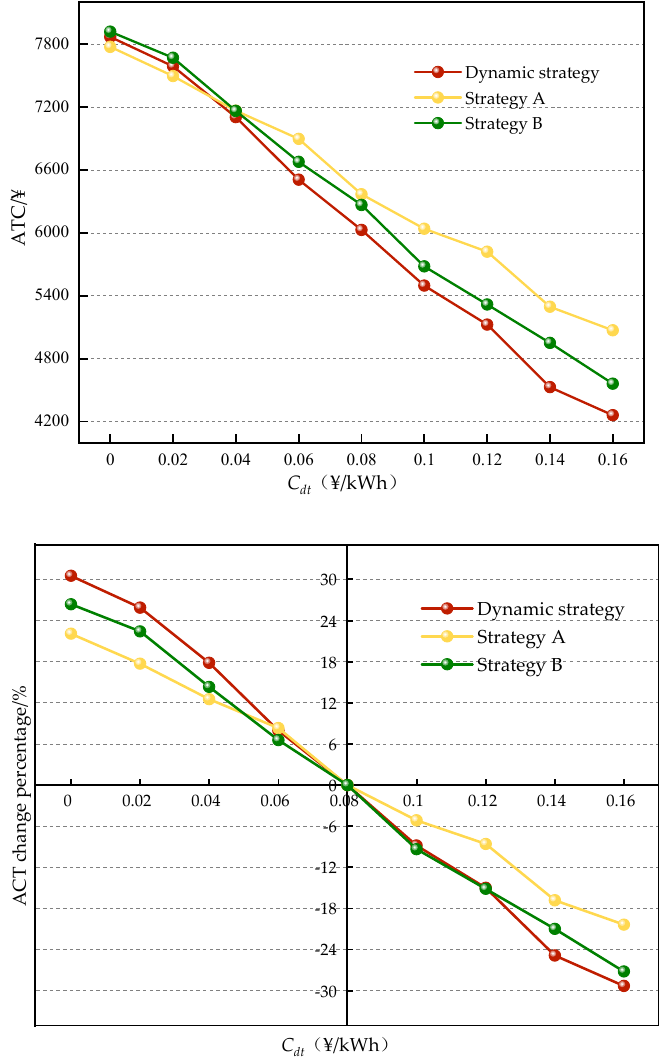
Figure 9. The impact of C dt on ACT under different operating strategies.